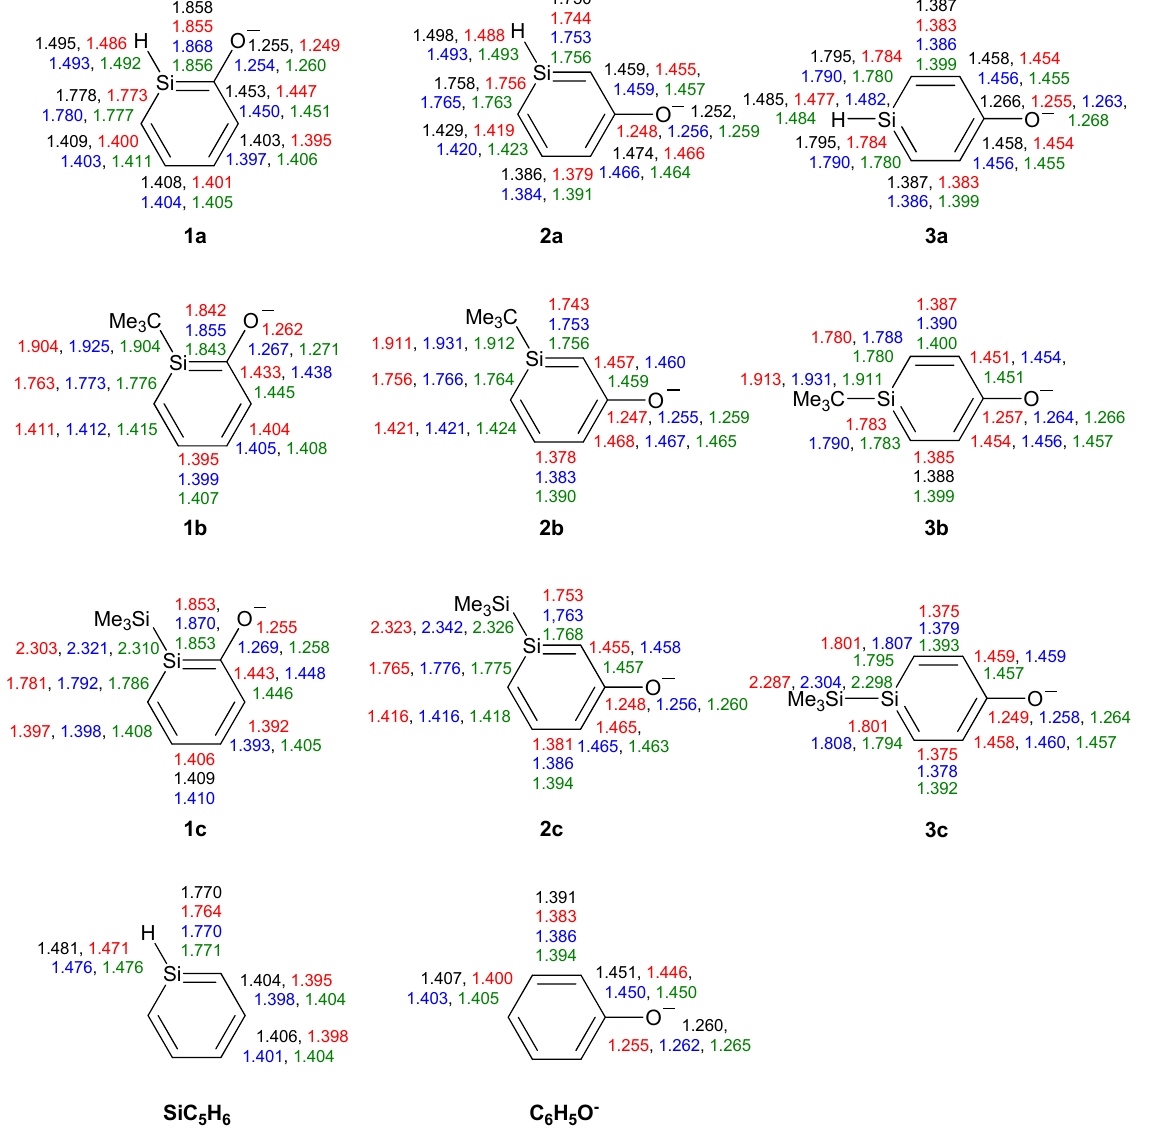
H and all-carbon 5 6